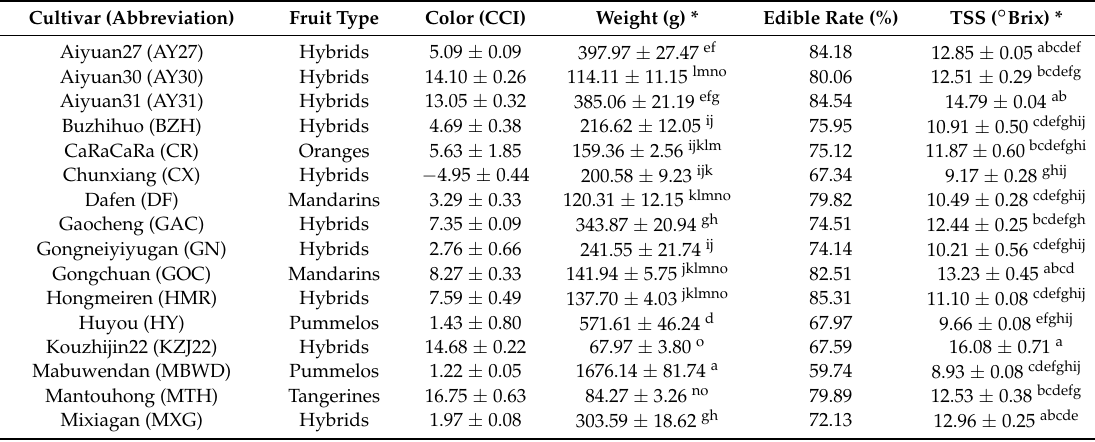
Table 1. Appearance and taste qualities of Citrus fruits of 35 cultivars. TSS = total soluble solids. Cultivar